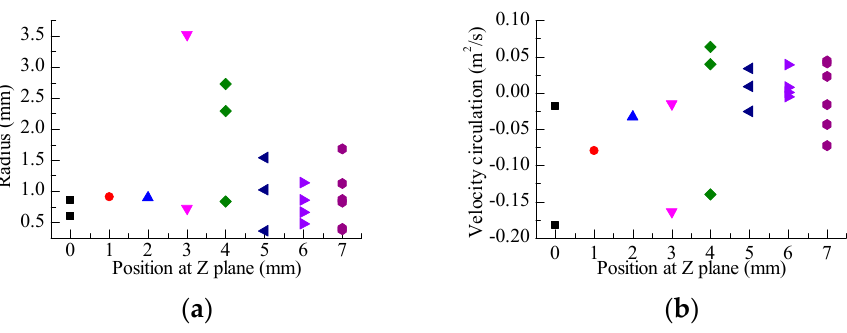
Figure 12. Position and radius of vortex at 202° BTDC. ( a ) Vortex radius; ( b ) velocity circulation.